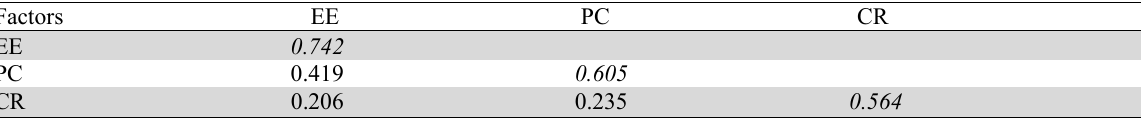
Discriminant validity